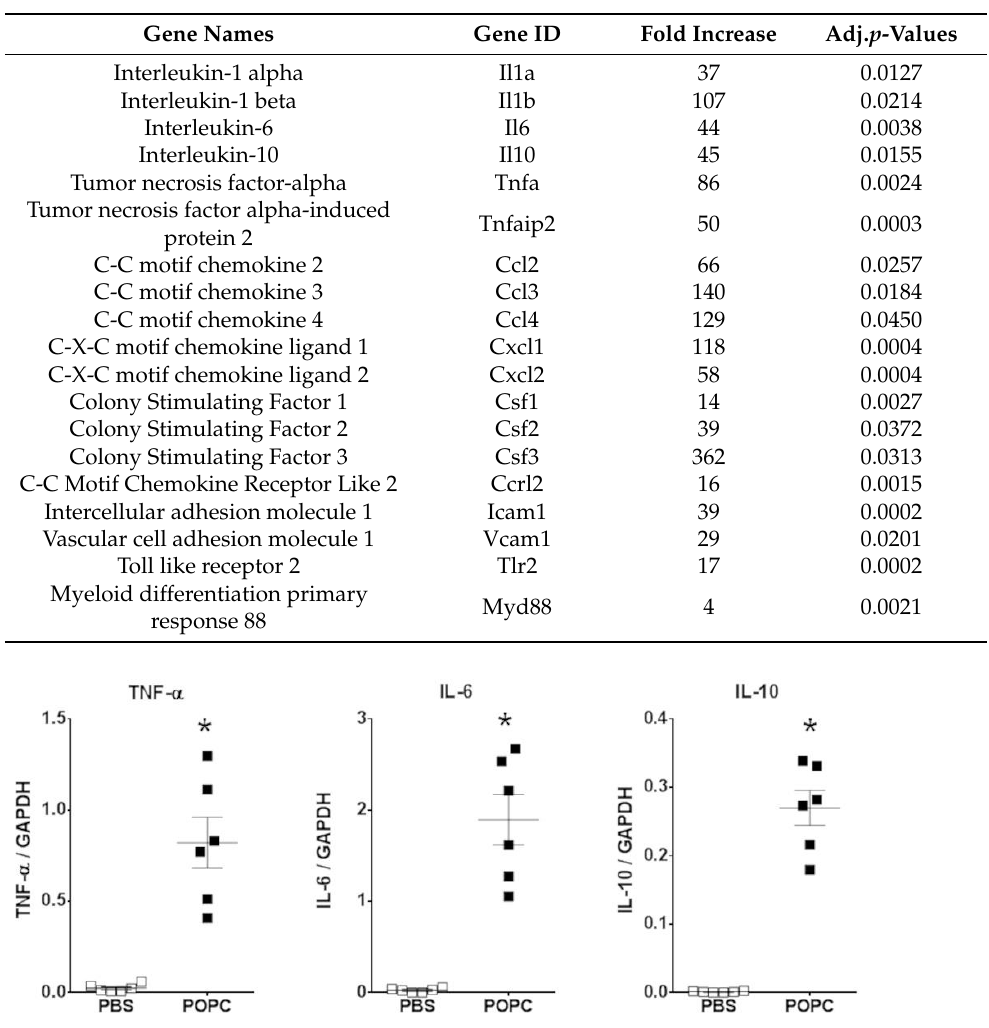
Table 2. Selected inflammatory genes with increased expression following POPC treatment.